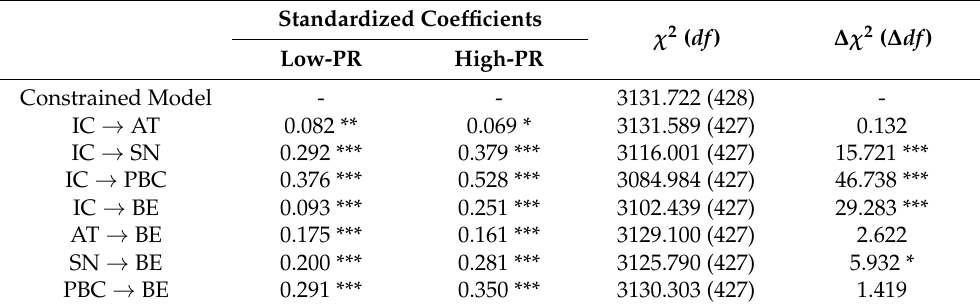
Table 6. Results of the multigroup